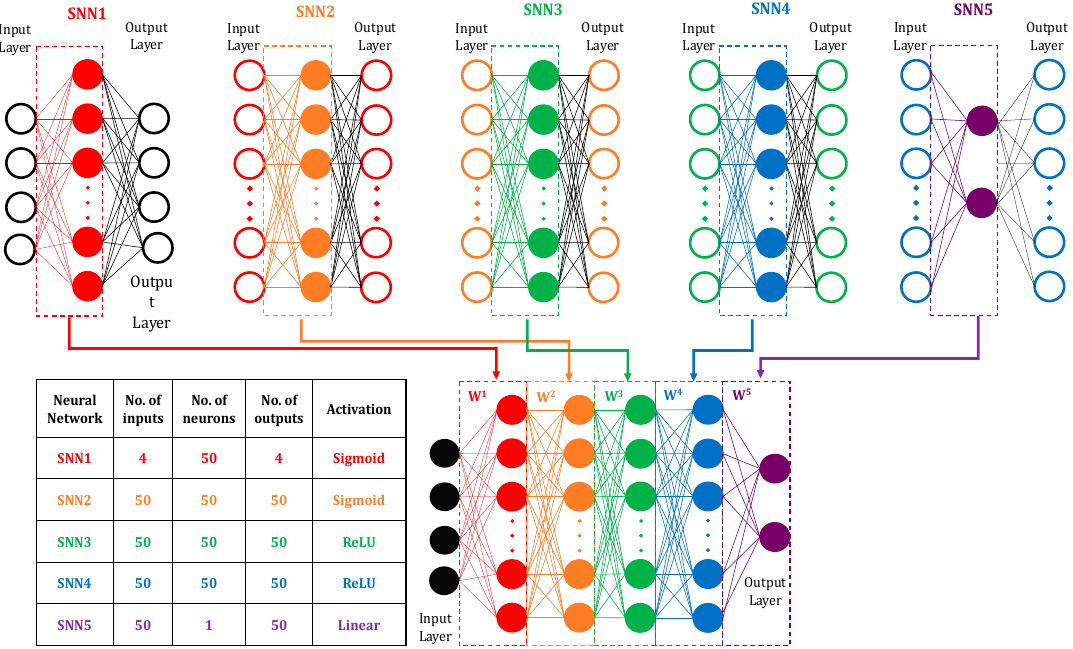
Figure 5. Deep learning neural network unsupervised greedy layer-wise pre-training approach.